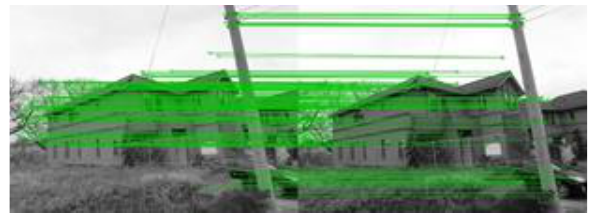
Figure 3. Feature points tracking